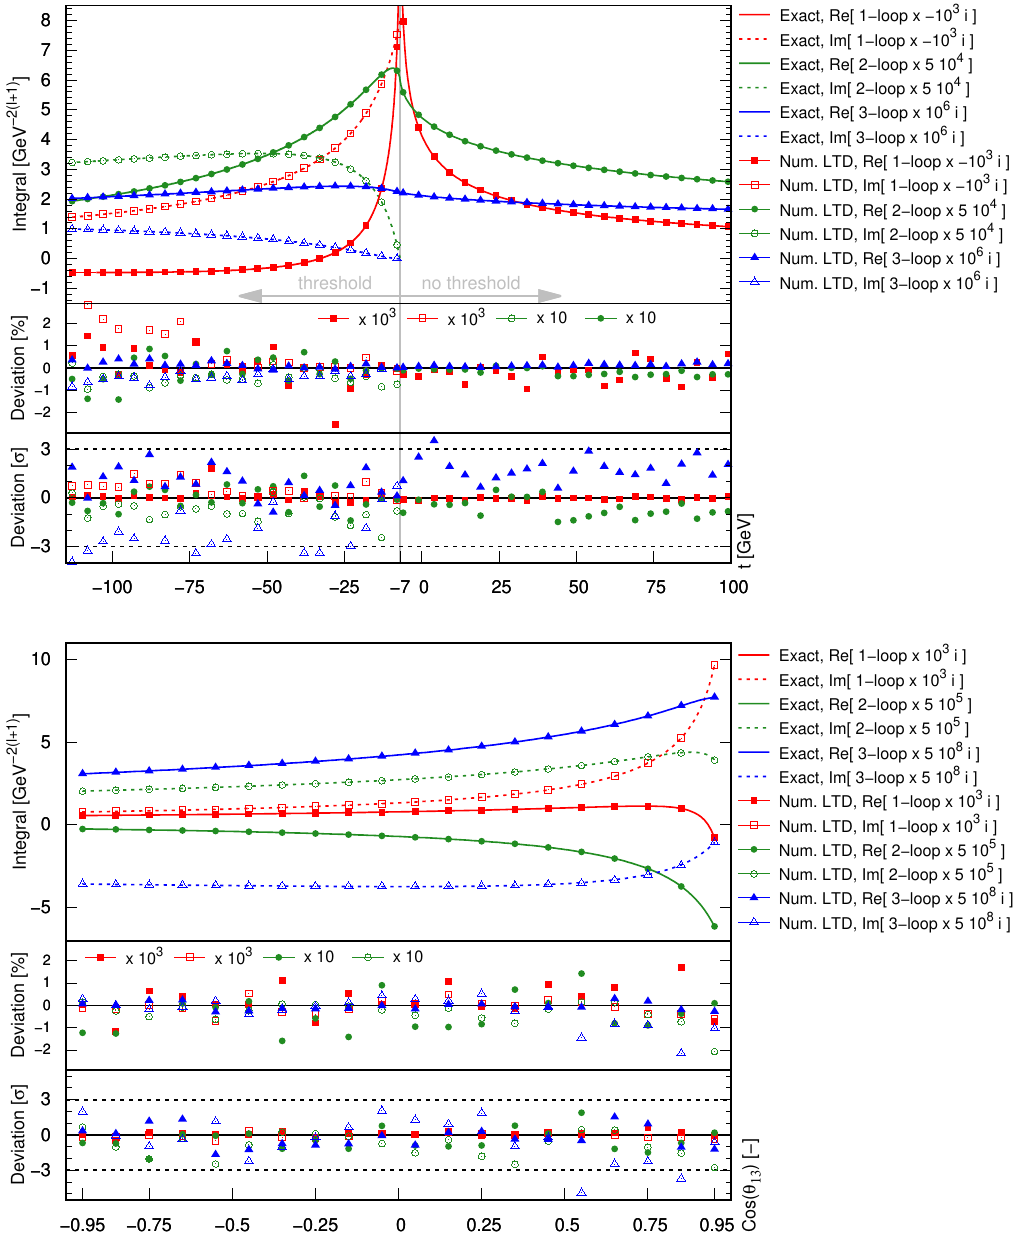
Figure 20. Comparison of the exact analytic result from ref. [99] with our numerical LTD computation for ladder 1-, 2- and 3-loop integrals. The kinematics considered for the top (cid:12)gure is p 2 = 5 and p 2 = p 2 = p 2 = ( p 1 + p 2 ) 2 = 1 and we scan over di(cid:11)erent values of the Mandelstamm 1 2 3 4 (cid:0) (cid:0) invariant t = ( p 1 + p 3 ) 2 . The kinematics of the bottom (cid:12)gure correspond to a physical 2 scattering with p 2 = 1, s = ( p 1 + p 2 ) 2 = 4 : 4 and we scan over di(cid:11)erent values of the 1 ; 2 ; 3 ; 4 f g scattering angle (cid:18) 13 = \ ( ~p 1 ; ~p 3